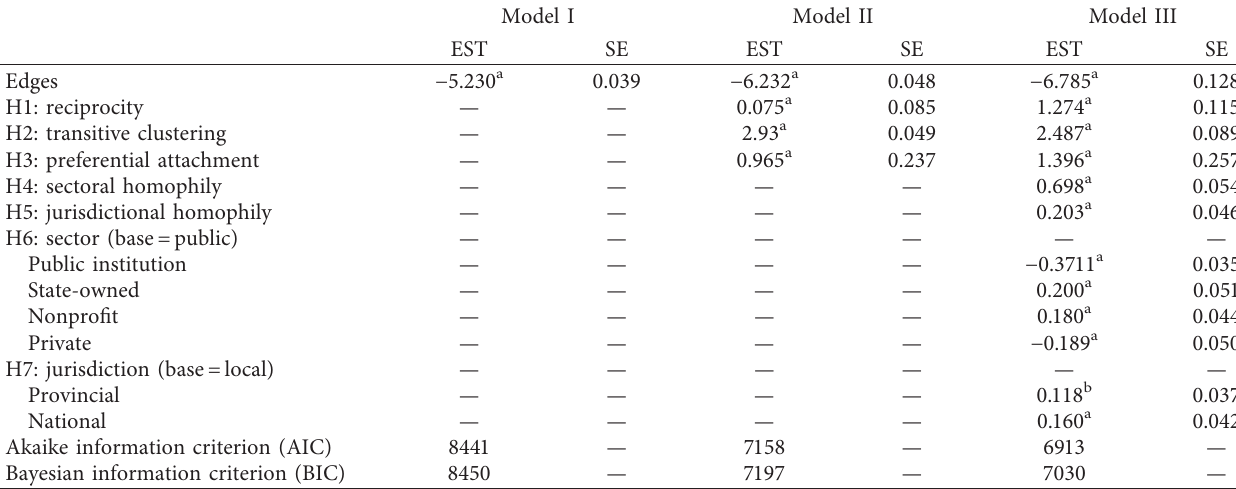
Table 4: Estimation results: estimates and standard